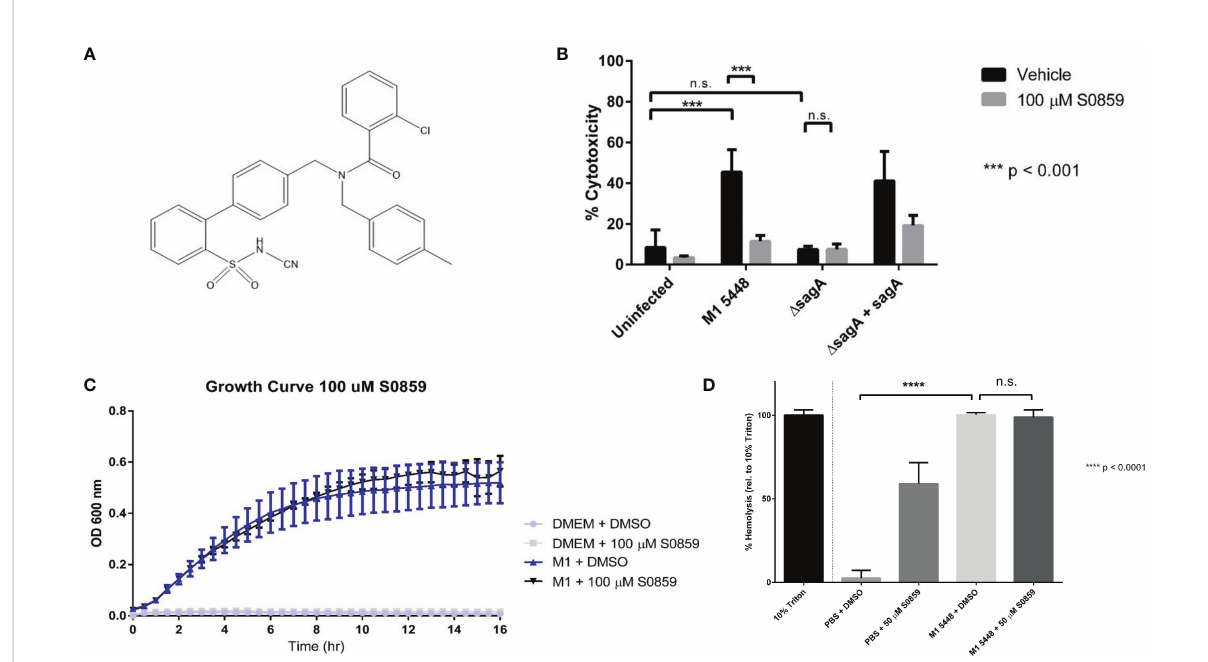
FIGURE 2 S0859 inhibits SLS-induced cytotoxicity in human keratinocytes, but not SLS-dependent hemolysis of erythrocytes. (A) Chemical structure of the N-cyanosulfonamide S0859. (B) Percent host cytotoxicity following 6 hour GAS infections of HaCaT cells (MOI 10) pre-treated for 1 hour with 100 µM S0859. Percent cytotoxicity was determined using an ethidium homodimer assay. DMSO was used as a vehicle control, and data are presented as mean ± sd, with n = 3 for each condition. (C) Growth curve of wild-type M1 5448 GAS in DMEM supplemented with 10% FBS in the presence or absence of 100 µM S0859. DMSO was used as a vehicle control, and un-inoculated DMEM + 10% FBS was used for each treatment condition as a sterility control. (D) Percent hemolysis (relative to 10% triton) induced by a 1 hour incubation of SLS preparations with erythrocytes in the presence of DMSO (Vehicle) or 50 µM S0859. *** = 0.0001 < P < 0.001, n.s. = not signi fi